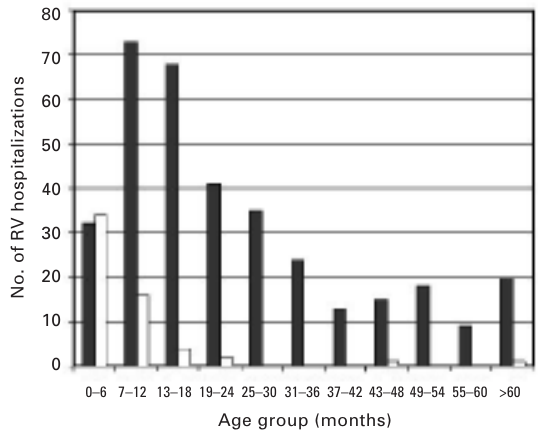
years 2002 and 2003 there were 219 and 212 hos- all causes. The monthly proportion of all gastroen- teritis cases caused by RV ranged from 0% in sum- mer to a maximum of 60 to 74% in late winter and early spring. Overall, 38% of hospitalisations for gastroenteritis were associated with RV.